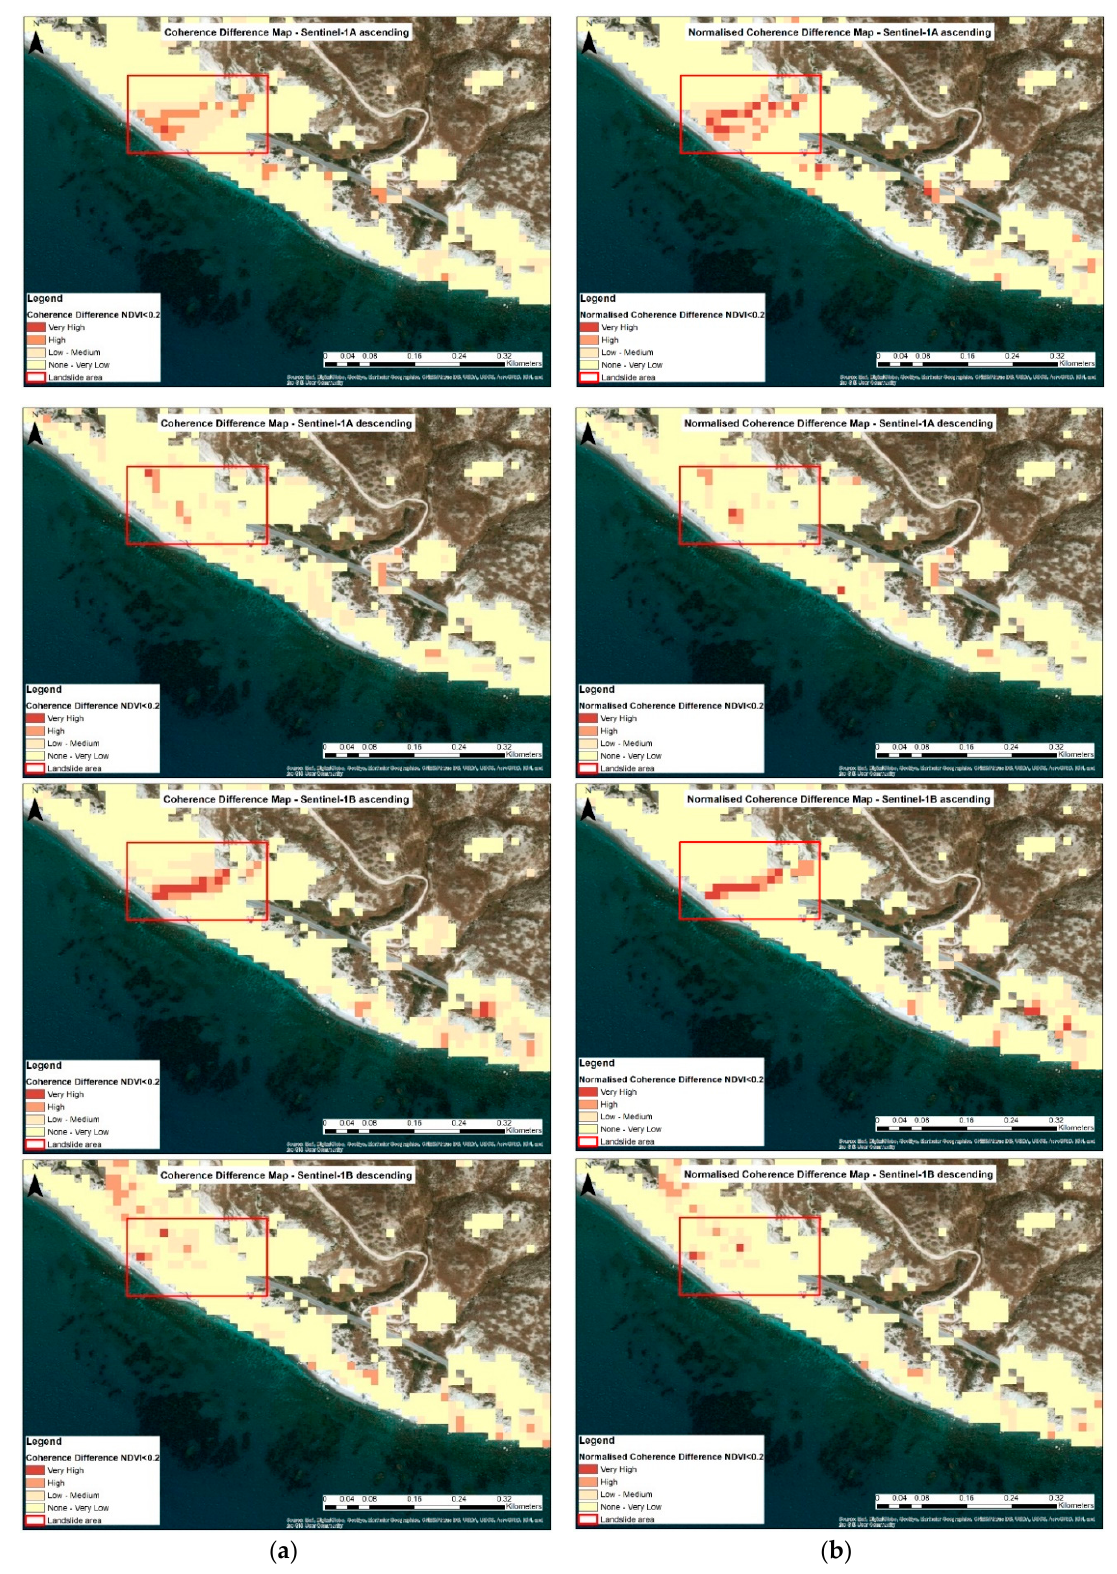
Figure 23. ( a ) Coherence difference and ( b ) normalized coherence difference maps – Sentinel-1A ascending (first), Sentinel-1A descending (second), Sentinel 1-B ascending (third), and Sentinel-1B descending (fourth).